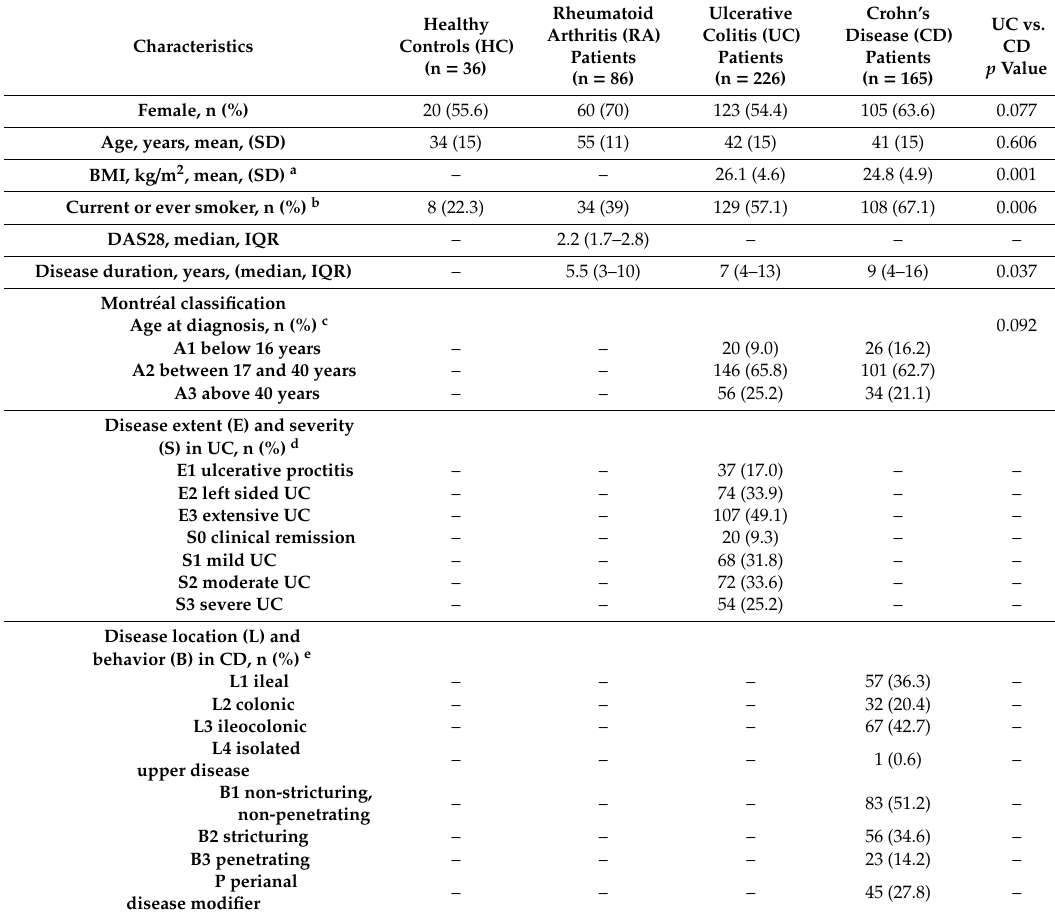
Table 1. Subject